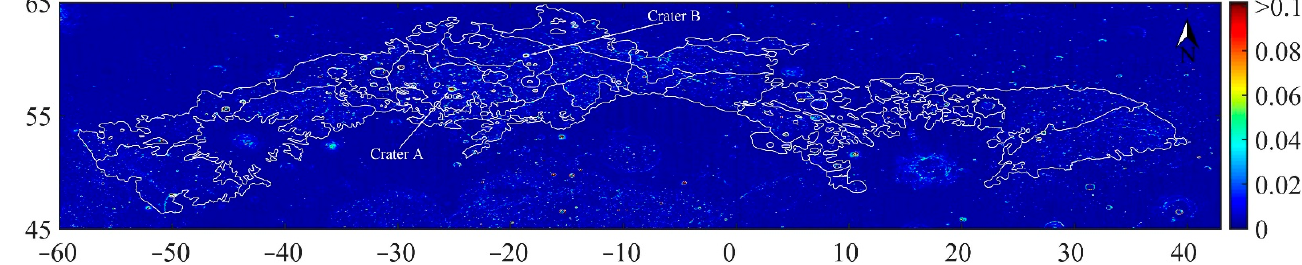
Figure 15. Rock abundance map of Mare Frigoris (equidistant cylindrical projection). The white lines are the geologic boundaries of Mare Frigoris mapped by Kramer et al. [2]. The rock abundance data were downloaded from https://ode.rsl.wustl.edu/moon/index.aspx (accessed on 21 February 2013).